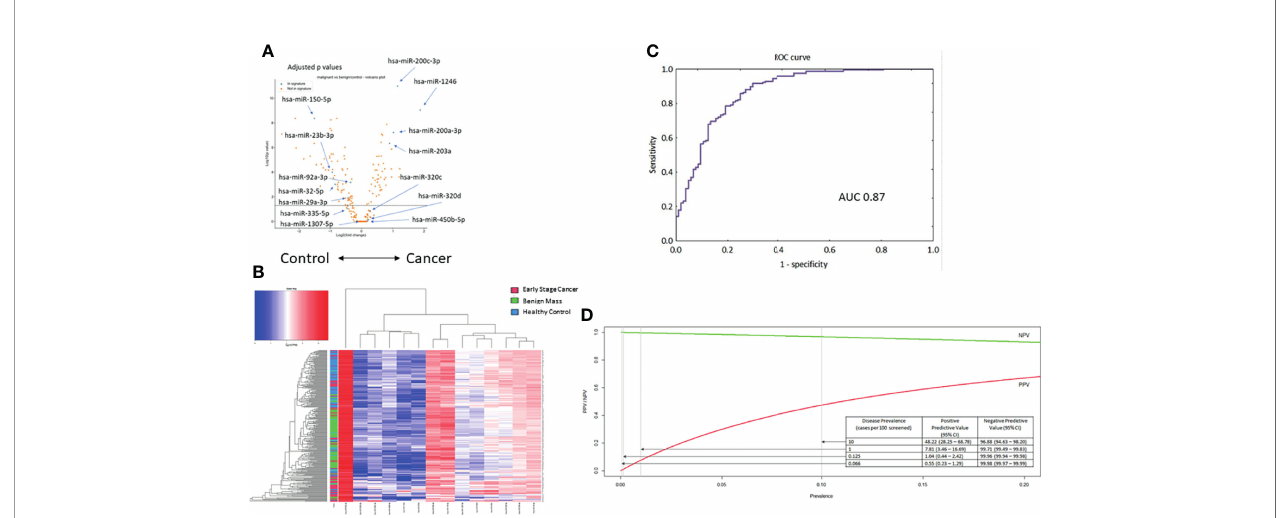
FIGURE 3 | Testing the 14-miRNA signature in the early-stage ovarian cancer cohort (n = 275). (A) Volcano plot for all miRNAs in the samples. Selected miRNAs from the neural network are highlighted. Values adjusted for multiple testing. (B) Unsupervised hierarchical clustering using only the 14 miRNAs previously reported in the serum neural network. (C) Receiver operating characteristic curve for the neural network to distinguish early-stage cancer from benign masses or healthy controls (AUC = 0.87). (D) Modeling the performance of the neural network classi fi er by disease prevalence among hypothetical